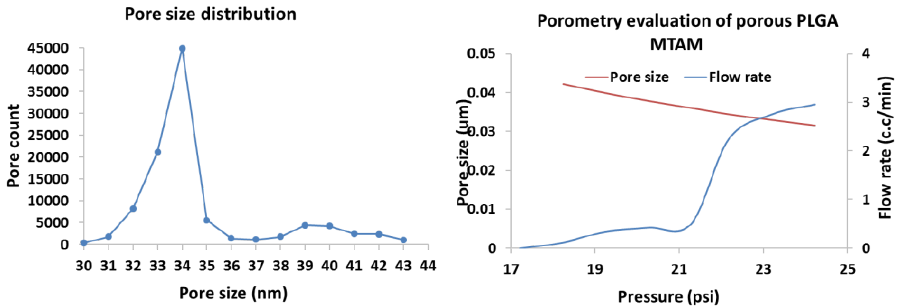
Figure 2. Porometry evaluation of PLGA MTAMs. The pore size distribution of the PLGA registered a mean pore size of 34 nm with a relatively narrow distribution ( left ), while the maximum burst pressure for the PLGA MTAMs was 1253.05 mmHg ( right ).